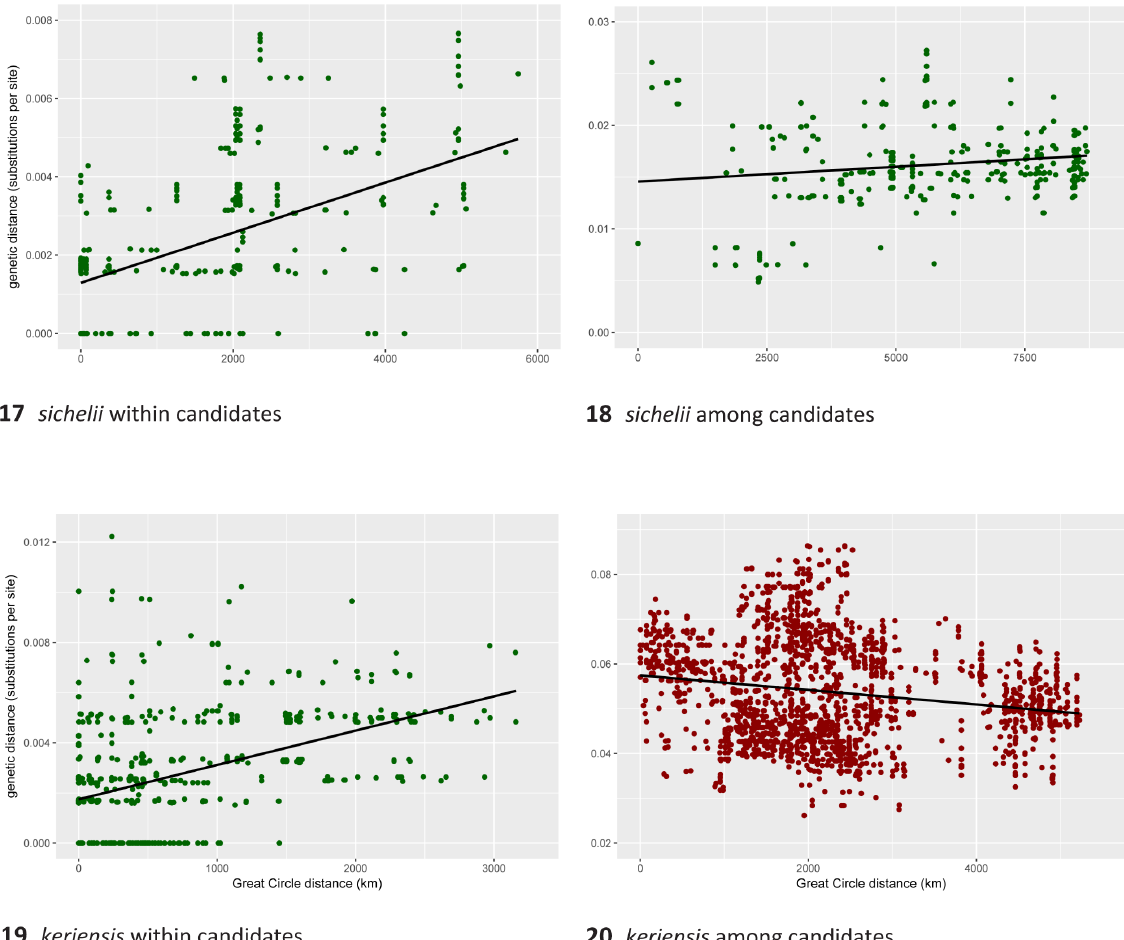
Figs 17–20. Plots of ( y - axis) pairwise proportion of genetic divergence between COI barcode region sequences against ( x - axis) pairwise Great Circle geographical distance in km between sample sites with linear trend lines (black). 17 . Genetic divergences within the candidate species for the sichelii -complex identified using Bayesian UF-PTP (Mantel r = 0.52). 18 . Genetic divergences among the candidate species for the sichelii -complex identified using Bayesian UF-PTP (Mantel r = 0.21). 19 . Genetic divergences within the candidate species for the keriensis -complex identified using Bayesian UF-PTP (Mantel r = 0.16). 20 . Genetic divergences among the candidate species for the keriensis -complex identified using Bayesian UF-PTP (relationship not positive). For details of the measurements see the